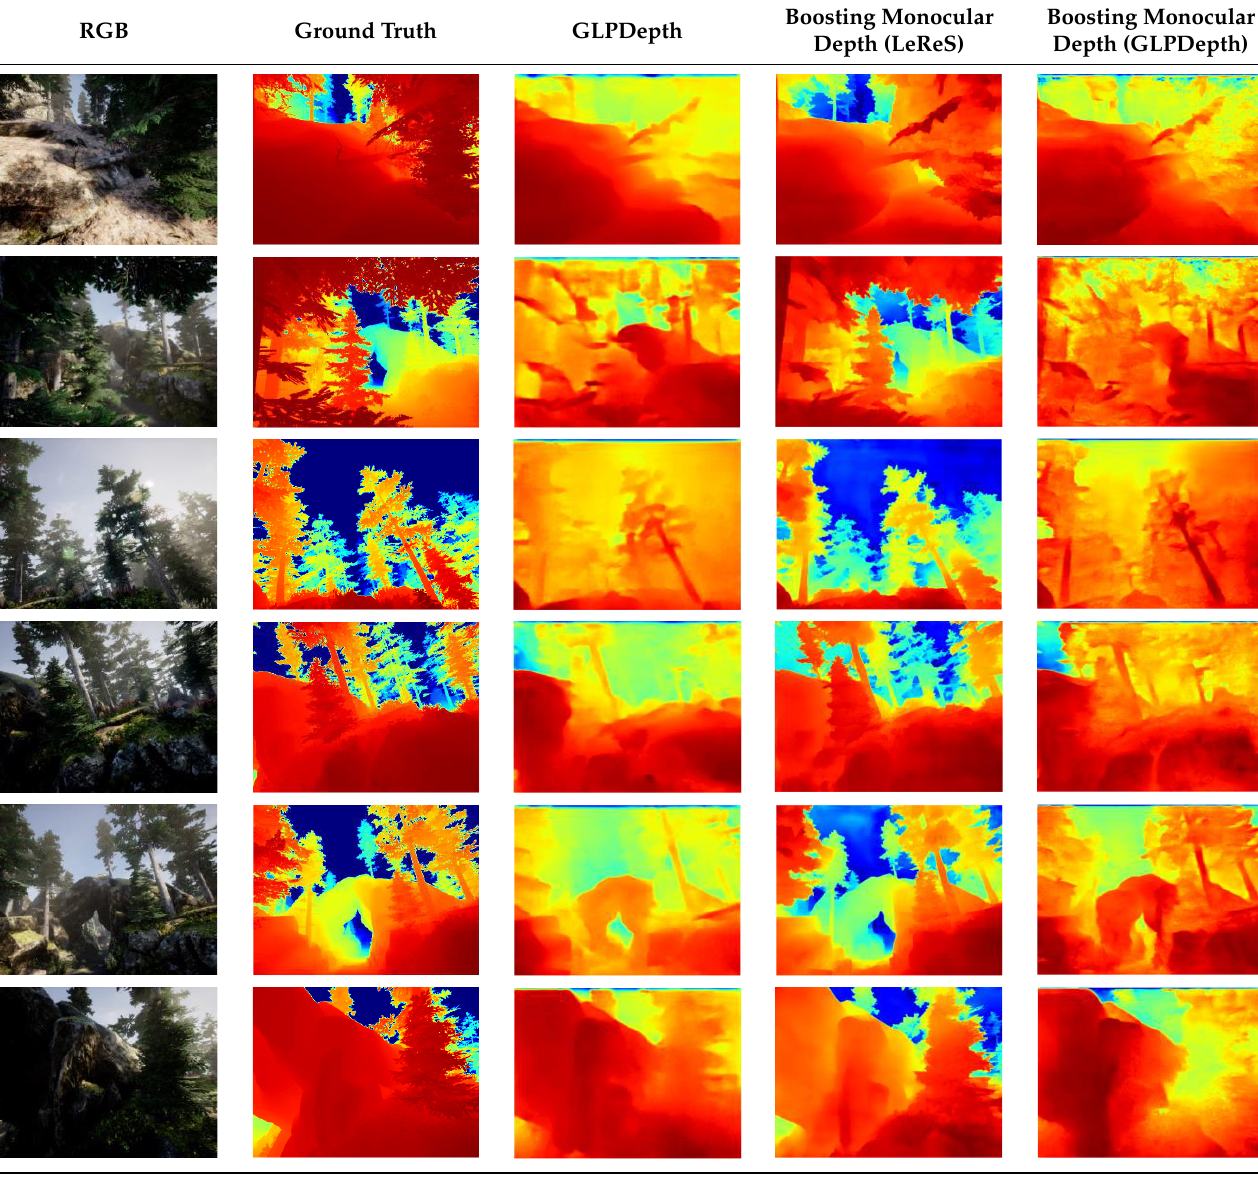
Table 9. Comparison results of depth estimation on the Gascola trajectory; the values in bold are the best results using GLPDepth and Boosting Monocular Depth